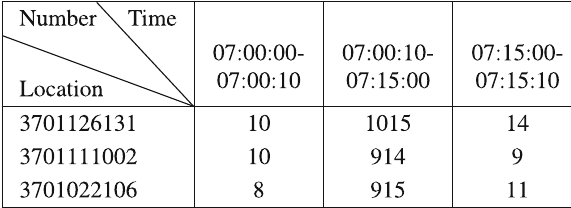
Table 2 Monitoring node N 2 maintains the records information